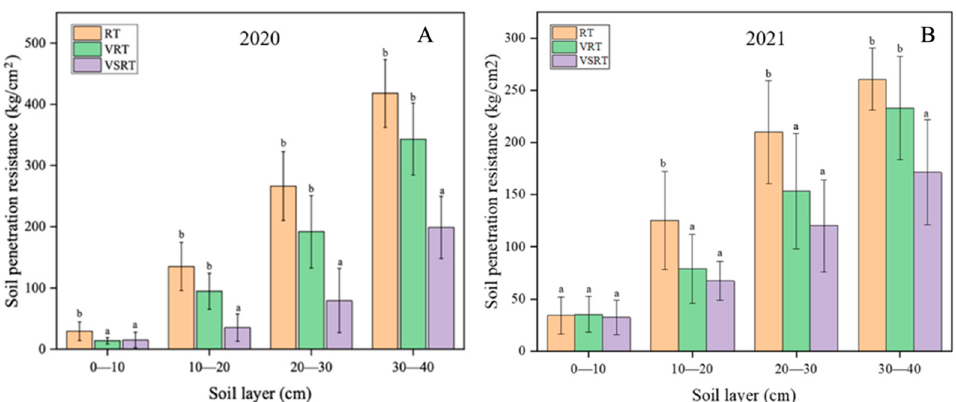
Figure 4. Soil penetration resistance in the 0–40 cm soil layer with the three tillage methods. ( A ): The soil penetration resistance in 2020; ( B ): The soil penetration resistance in 2021. Different lowercase letters in the same soil layer indicate significant differences at a p < 0.05 level. Rotary tillage, RT; vertical rotary tillage, VRT; vertical smashing rotary tillage, VSRT.